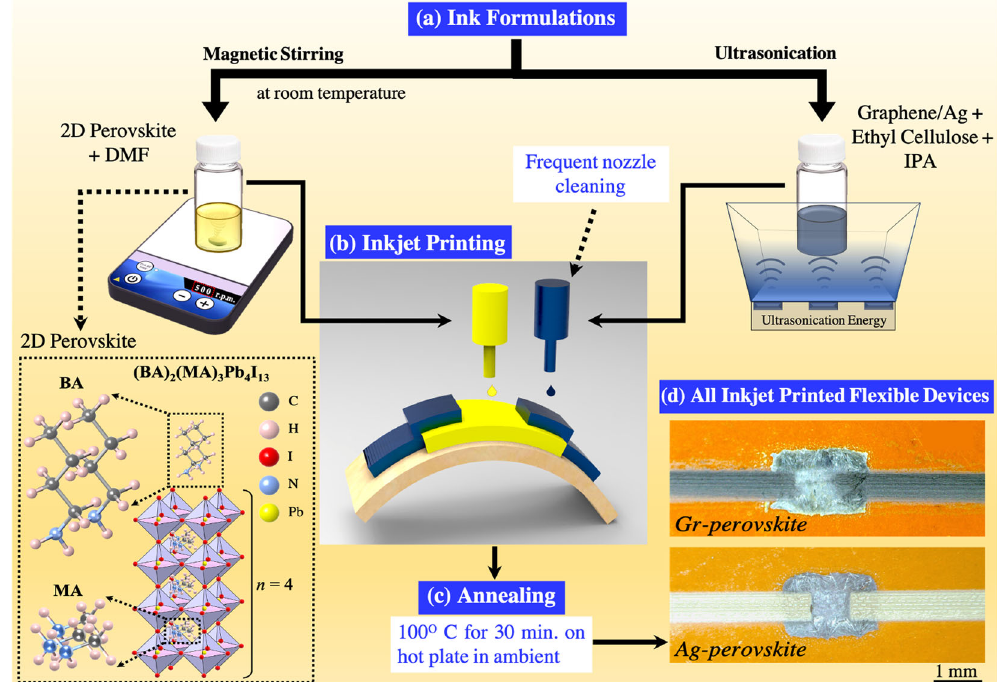
Fig. 1 Complete fabrication process. A complete process fl ow is shown in this fi gure that provides a pictorial representation of the ink formulation features in ( a ), inkjet printing in ( b ), annealing in ( c ), and micrographs of fabricated devices in ( d ). In ( a ), the perovskite (left) and Gr/Ag inks (right) were formulated using magnetic stirring and ultrasonication, respectively. The details of the ink formulations are explained in the “ Methods ” section. The bottom-left inset in ( a ) depicts the crystalline structure of (BA) 2 (MA) 3 Pb 4 I 13 , a family of n = 4 2D perovskite compounds, where the BA represents n -butylamine (CH 3 (CH 2 ) 3 NH 2 ), and MA is the methylammonium (CH 3 NH 3 ). b inkjet printing of the formulated perovskite (yellow ink) and Gr/Ag (blue ink), to form our heterostructure fl exible PD device. Frequent nozzle cleaning is necessary for the Gr/Ag ink as the IPA present in the Gr/Ag ink dries out fast. c Annealing of the perovskite and Gr/Ag layers was performed in both cases at 100 °C for 30 min at ambient, where the perovskite layer was annealed fi rst right after printing and then it was placed back into the platen to print the Gr/Ag layers and an additional annealing step was subsequently conducted. d Optical micrograph of the inkjet-printed fl exible Gr- perovskite and Ag-perovskite heterostructure PD devices on fl exible PI substrates with printed Gr (top) and Ag (bottom) contacts, where the metal contacts were printed on top of the underlying 2D perovskite